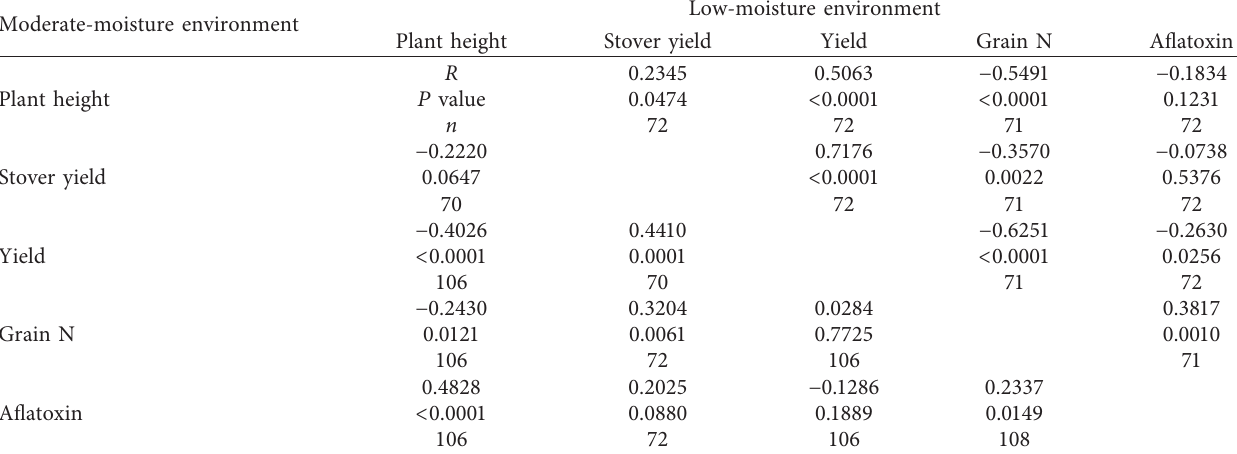
Table 7: Spearman’s rank correlation coefficients ( R ), P values, and number of observations ( n ) between plant height, stover yield, yield, grain N concentration, and aflatoxin values. Upper right cells are for the low-moisture environment; lower left cells are for the moderate- moisture environment.